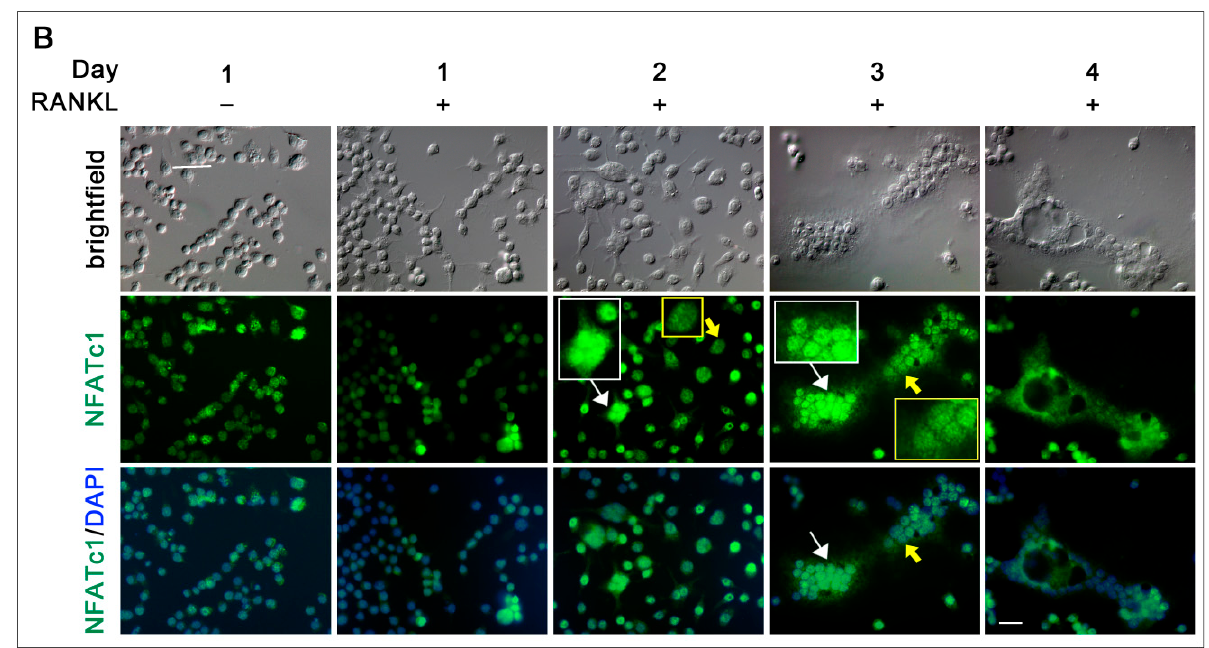
Figure 5. Timing of Receptor Activator of Nuclear factor κ -B Ligand (RANK) and NFATc1 subcellular localization. Cells were cultured in the absence (RANKL − ) or in the presence of RANKL (RANKL + ) for 4 days. ( A ) Cells co-stained with anti-RANK antibody (red) and DAPI (blue). White arrows, surface of multinucleated cells. Red frames and arrows indicate 1.5 × magnifications of cell membranes RANK-labelled. ( B ) Cells co-stained with anti NFATc1 antibody (green) and DAPI (blue). White frames and arrows indicate 1.5 × magnifications of nuclei with high NFATC1 staining intensity. Yellow frames and arrows indicate 1.5 × magnifications of nuclei with low NFATC1 staining intensity. The data shown represent two independent experiments with comparable outcomes. Magnification 40×. Scale bar of 50 µm.